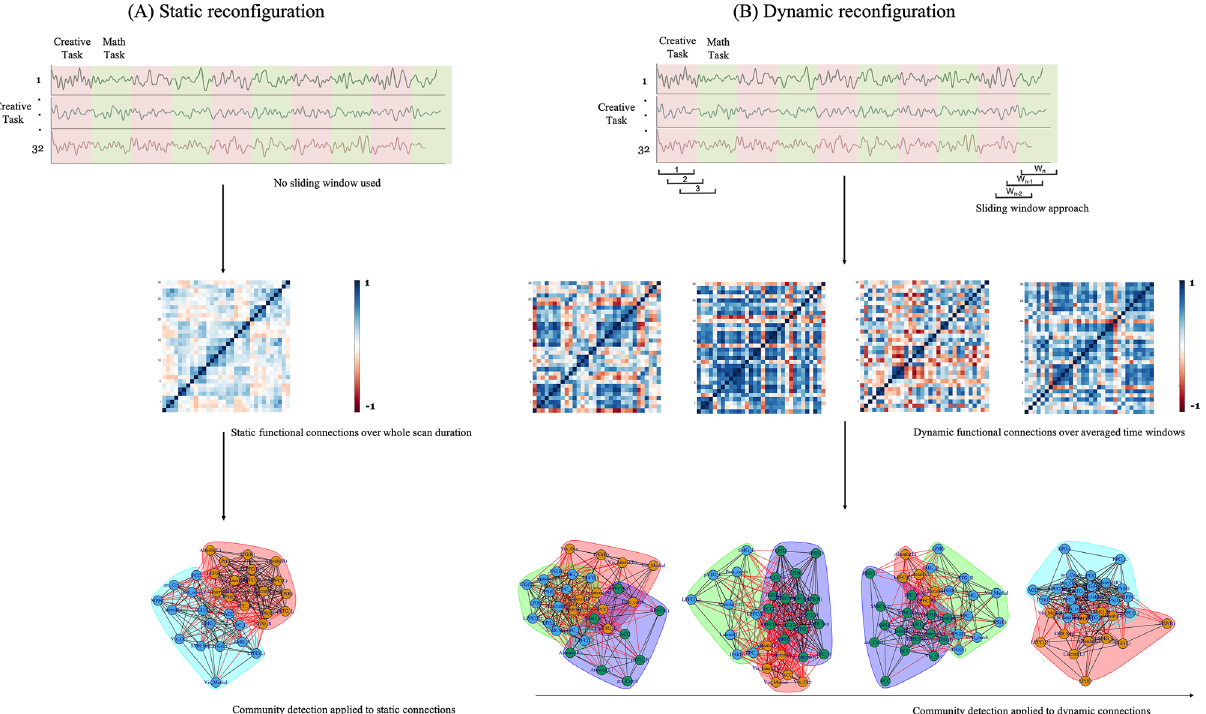
Figure 1. Overall flow of the static and dynamic network reconfiguration during creative thinking task. ( A ) Static reconfiguration. The Blood oxygen level dependent (BOLD) time series signal was extracted from each of the 32 regions of interests (ROIs). The z-scored Pearson correlation coefficients for 32 ROIs were calculated and a statistical threshold of p < 0.05, false discovery rate (FDR)-correction was applied to obtain the estimated correlation map. A single adjacency matrix was estimated and a community detection algorithm was applied to identify communities for the whole brain flexibility over the entire scan duration. ( B ) Dynamic reconfiguration. The Blood oxygen level dependent (BOLD) time series signal was extracted from each of the 32 regions of interests (ROIs). An overlapping sliding window (length W) was used and time ordered functional connectivity matrices were estimated over these windows for all the ROIs using z-scored Pearson correlation. The estimated correlation maps W n (n is number of windows) were statistically thresholded with p < 0.05 (FDR correction). A community detection algorithm was applied to all these matrices to detect communities across the